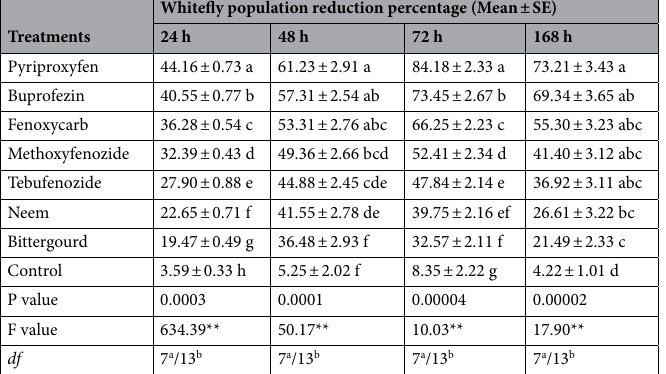
Percent parasitism of whitefly by E. formosa (Mean ± Treatments